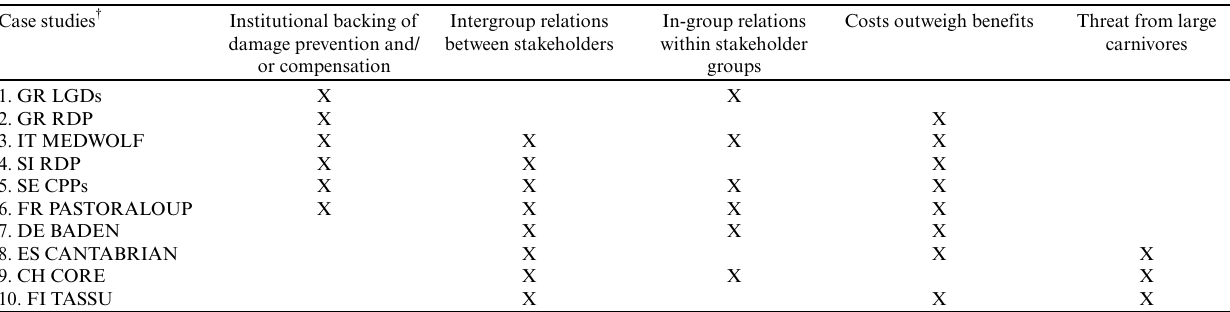
Table 2. Categories of trade-offs identified across case